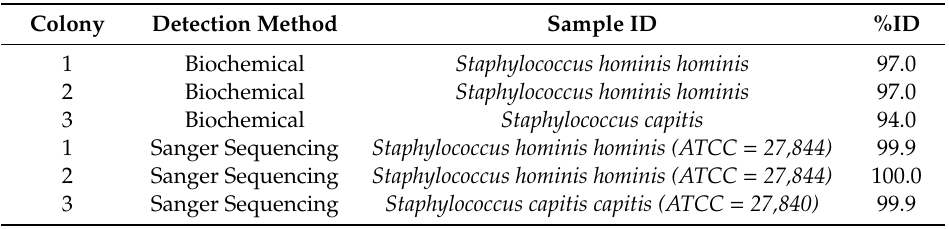
Figure 3. Percentage of reads assigned to microbial species cultured on the International Space Station and analyzed through in situ nanopore sequencing and return analysis on Earth. Reads were assigned to species in the National Center for Biotechnology Information 16S database based on alignments using minimap2 (-ax map-ont). The microbial culture was performed aboard the International Space Station. Nanopore sequencing library was prepared and sequenced on the International Space Station by Whitson. Ground control library was prepared and sequenced at the Johnson Space Center Houston, TX using the same prepackaged reagent kits. Table 1. Sample identification of returned microbial samples from ISS using VITEK 2 biochemical profiling and 3500 Sanger